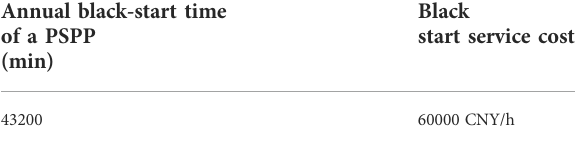
TABLE 6 Black-start service for PSPP.